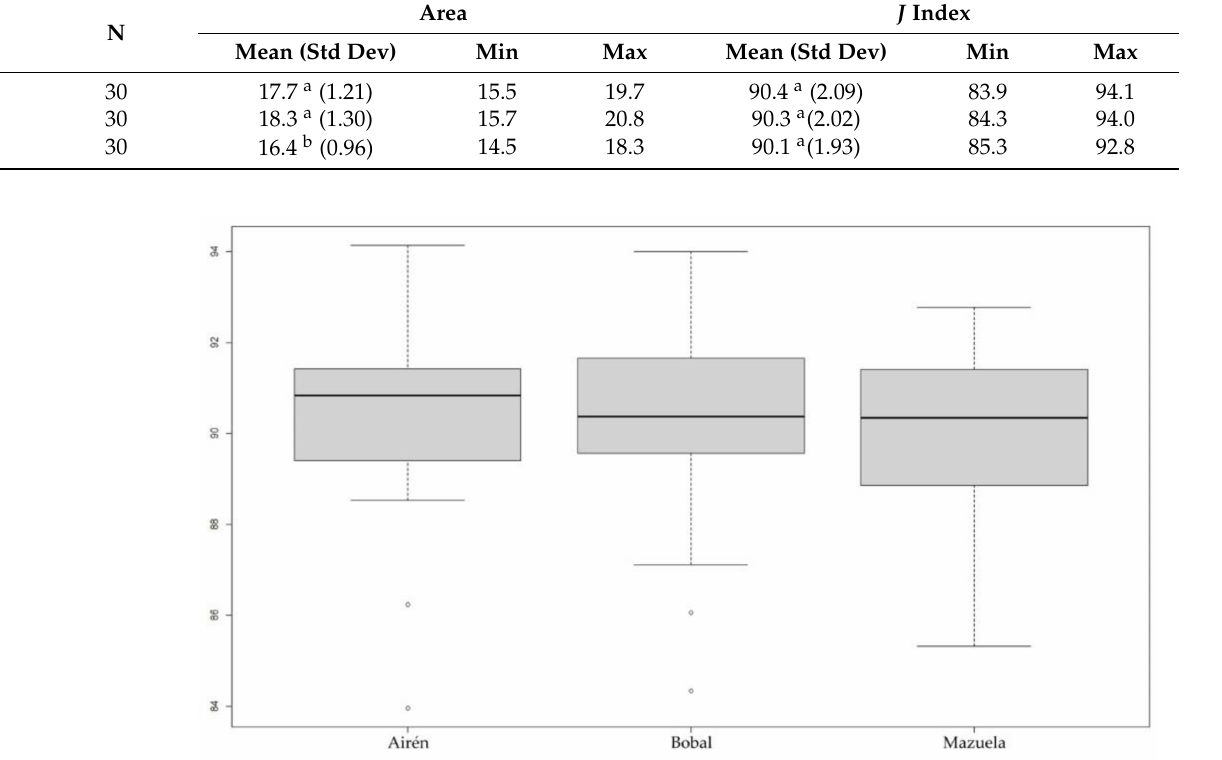
Figure 21. Box-plot representations showing the distribution of J index values in cultivars Air é n, Bobal and Mazuela with the Air é n